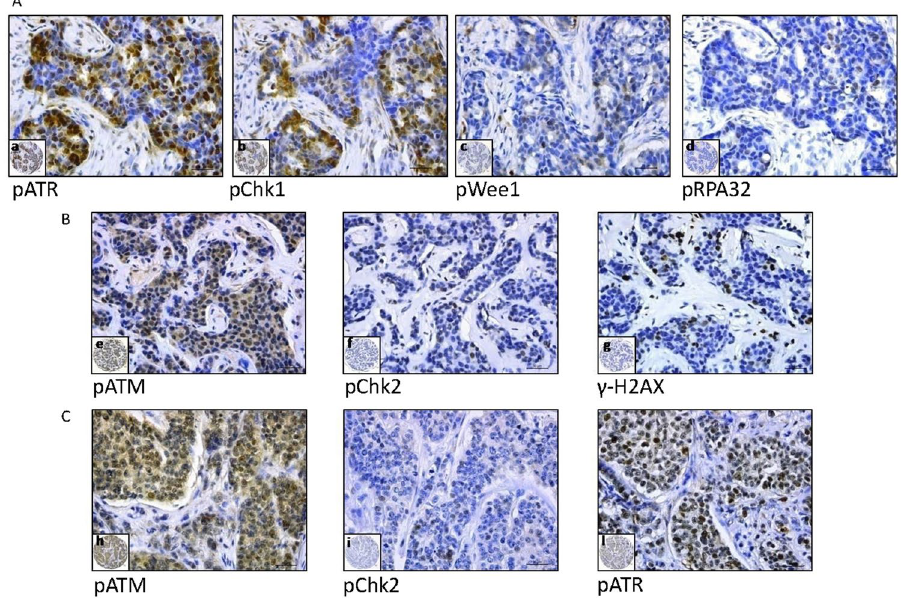
Figure 2. Representative examples of immunohistochemical expression of pATR, pChk1, pWee1, pRPA32, pATM, pChk2 and γ -H2AX in three male breast cancer patients ( A , B , C ). Panels a–d show a sample with nuclear expression of pATR, pCHK1, pWEE1 and pRPA32 ( A ). Panels e–g show a sample with nuclear expression of pATM, pCHK2 and γ -H2AX ( B ). Panels h–l show a sample with nuclear expression of pATM,